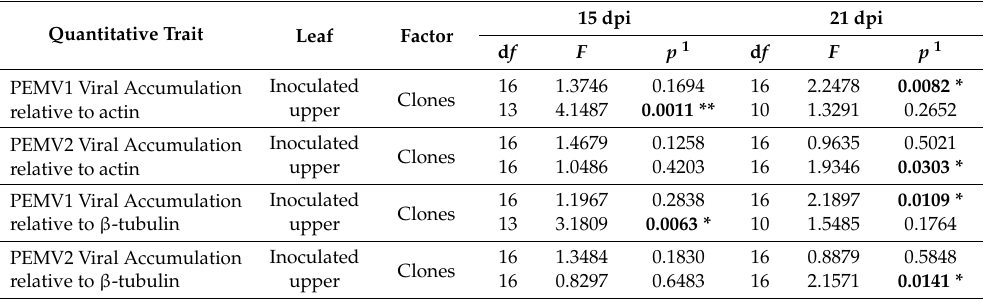
Table 2. Effects of PEMV coat protein mutations on PEMV1 and PEMV2 accumulation relative to two housekeeping gene RNAs at 15 and 21 dpi. Quantitative